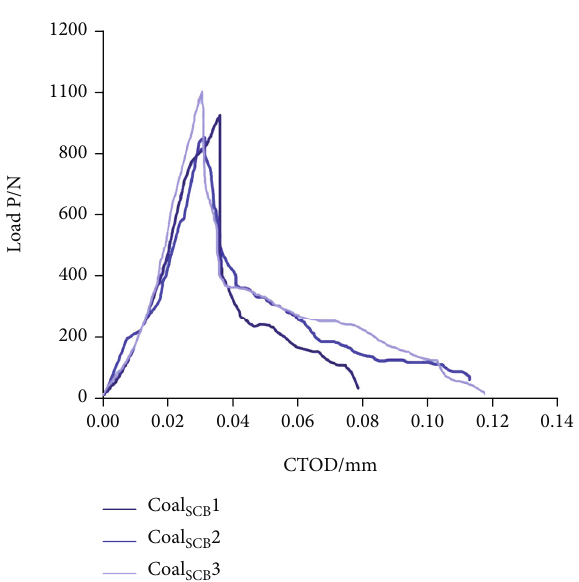
Figure 3: Loading-CTOD curve of coal SCB